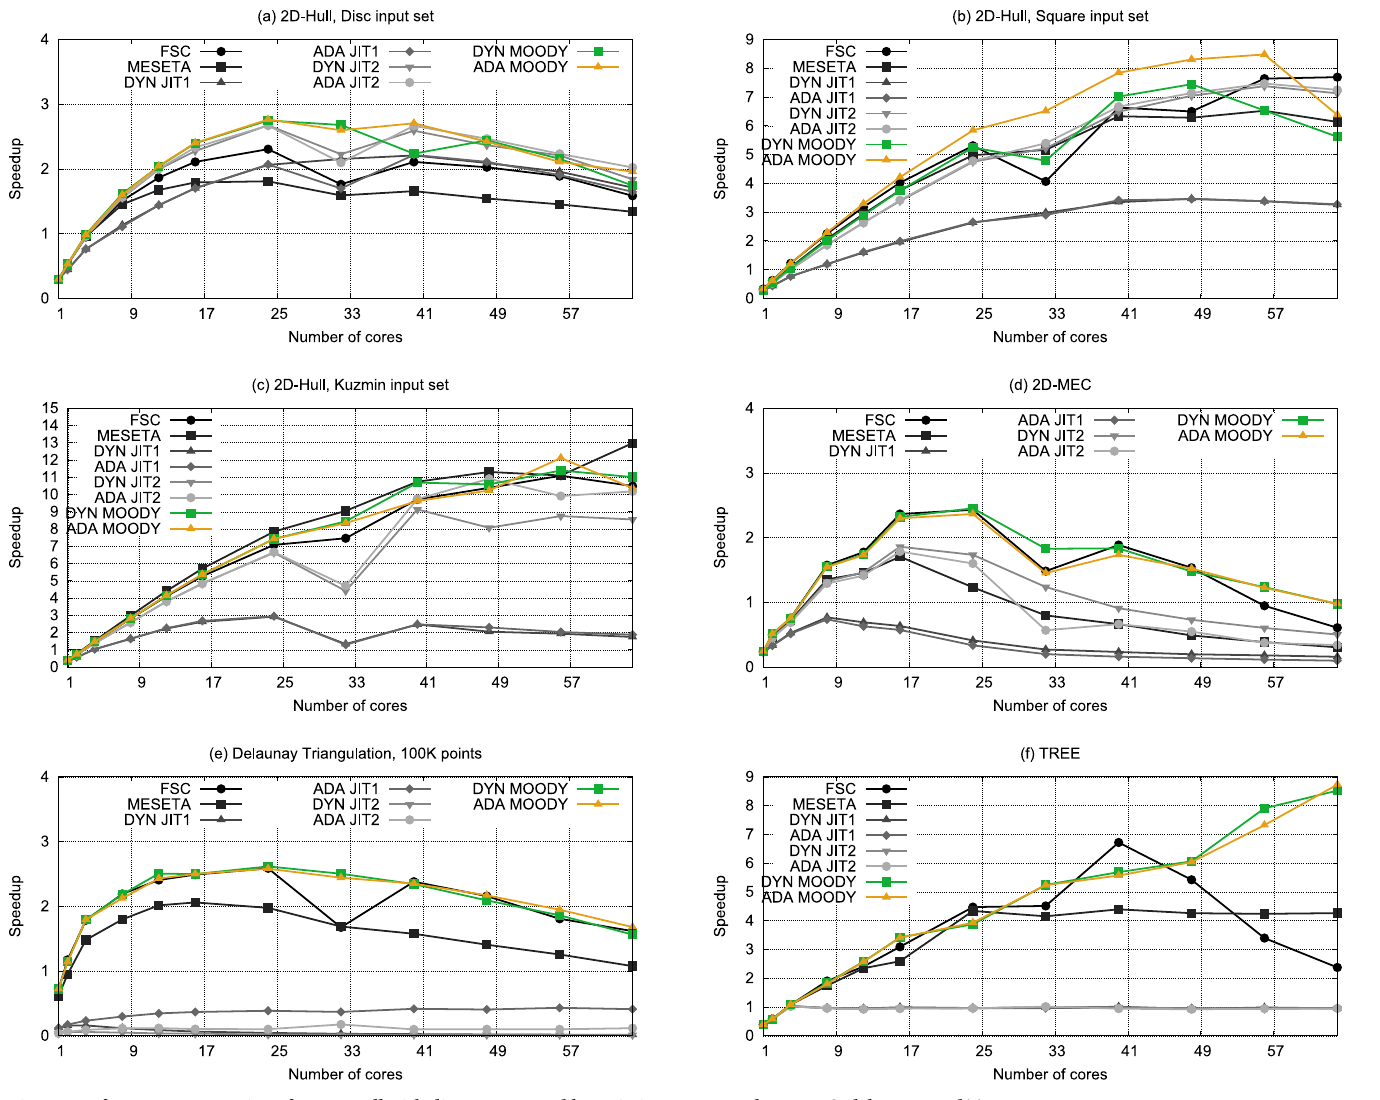
Fig 10. Performance comparison for 2D-Hull with disc, square, and kuzmin input sets, and 2D-MEC, delaunay, and